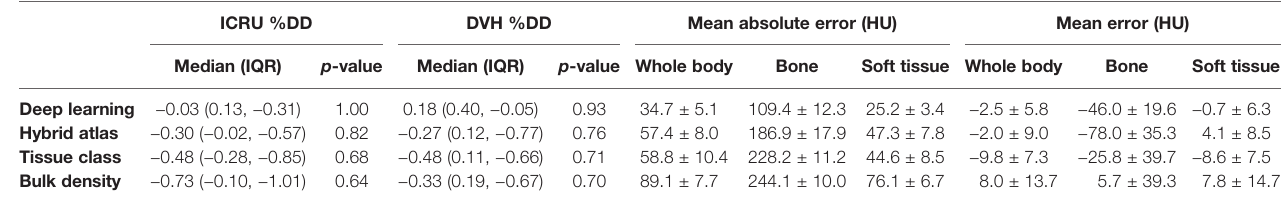
TABLE 3 | ICRU median percentage dose difference and median DVH dose difference by the sCT method.